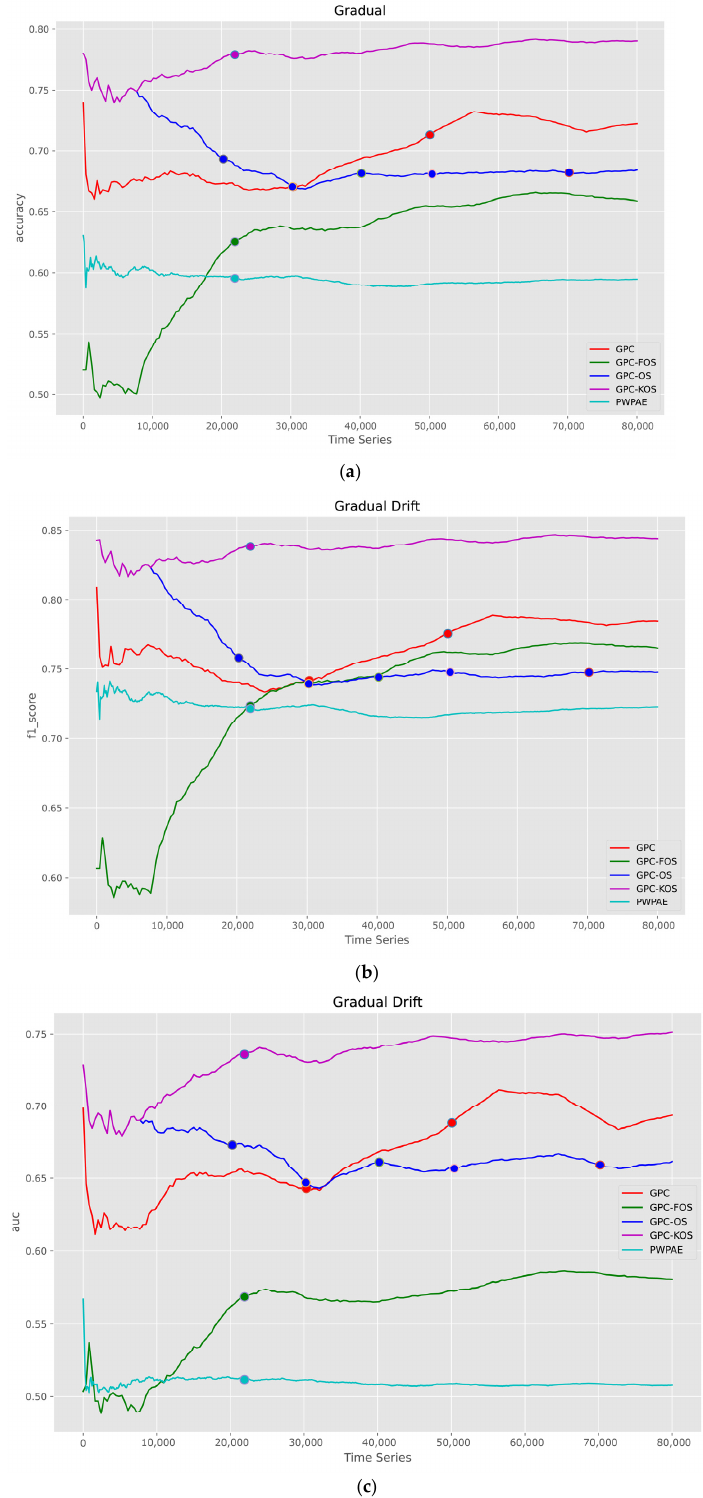
Figure 8. Visualisation of classification metrics as time series for a gradual type of drift—( a ) accuracy, ( b ) F1-score, ( c ) AUC.